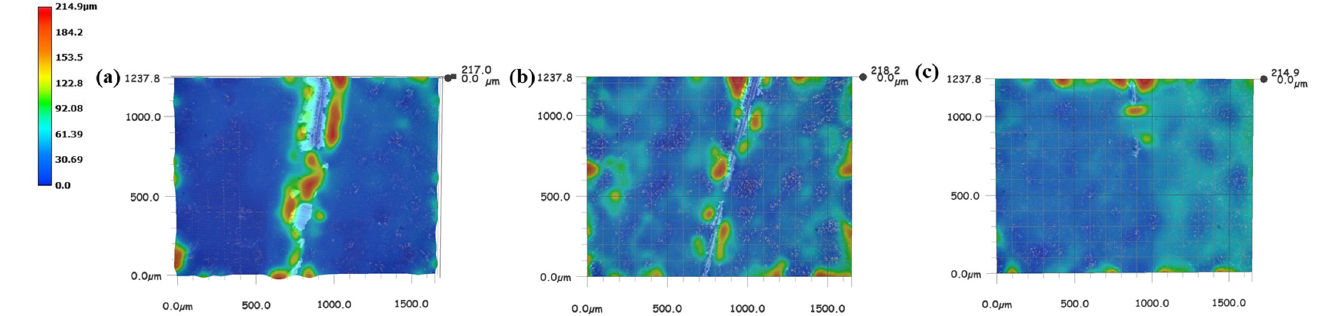
Figure 12. The 3D morphology of a Ce(IV)/PEI-C/PAA-GO-coated surface: ( a ) surface incision, ( b ) 10-min self-repair, and ( c ) 20-min self-repair.